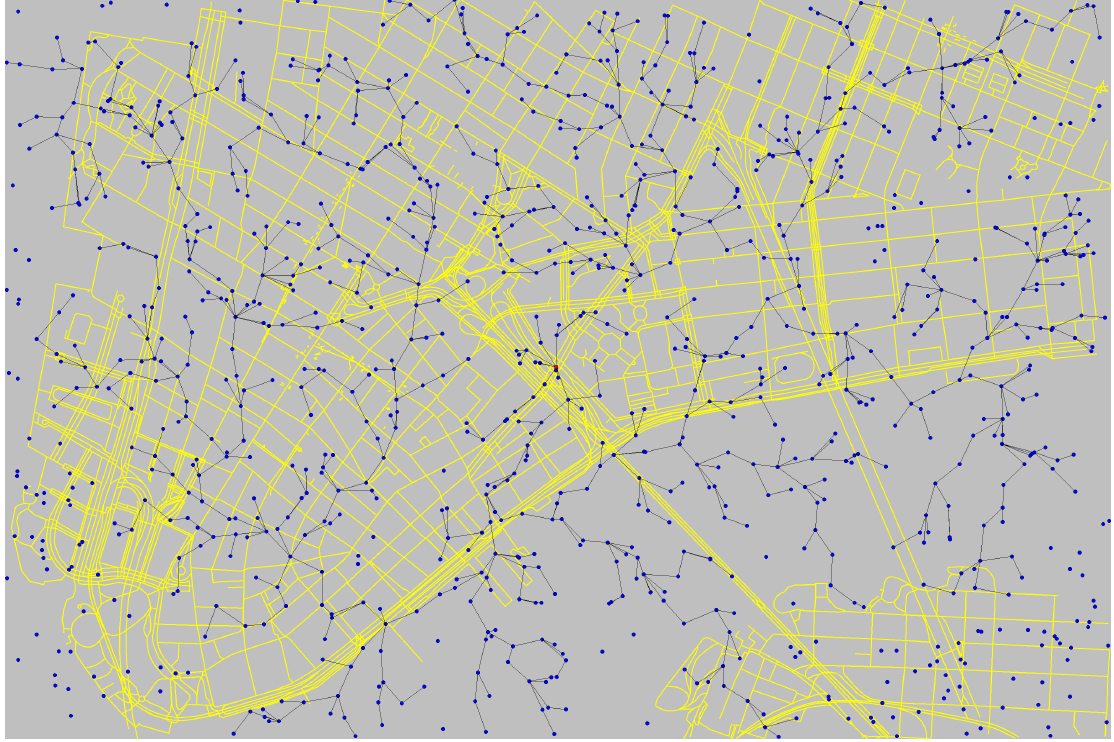
Figure 12. Subregion of Manhattan that was considered for the simulations. In total, 1000 sensors were randomly